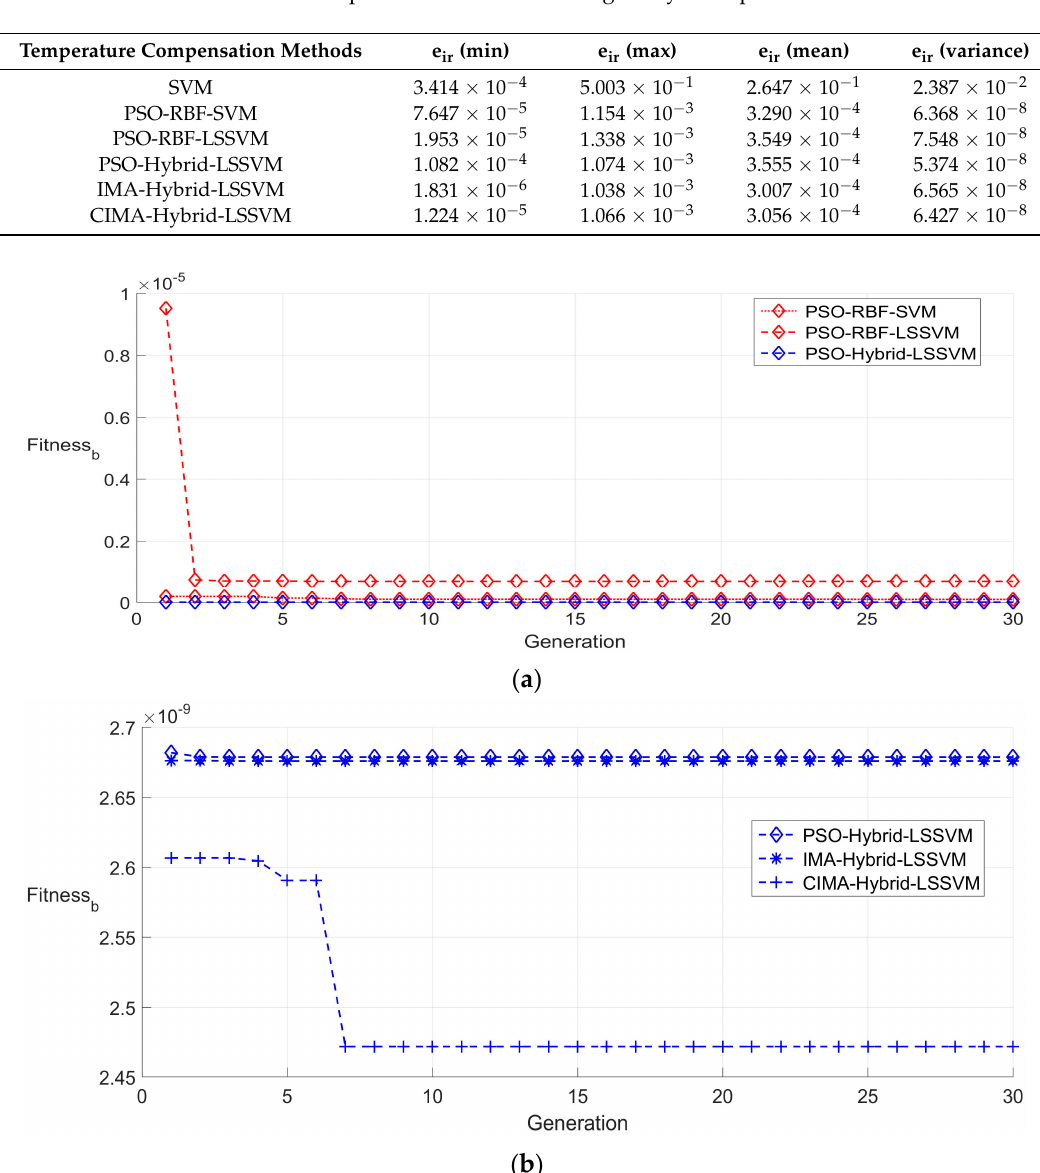
Figure 8. Best fitness of training set by fixed partition in 30 generations. ( a ) best fitness obtained by